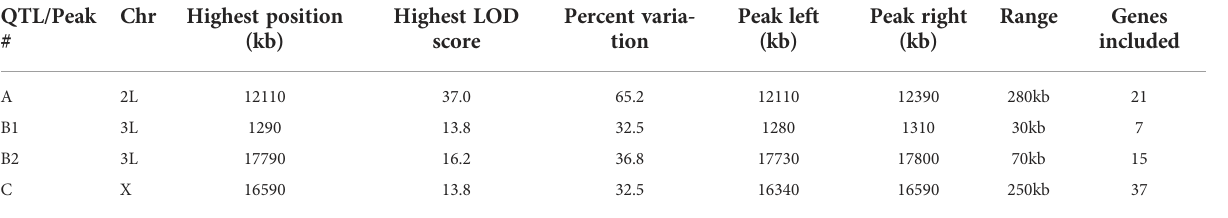
TABLE 1 QTL/LOD peaks identi fi ed in QTL analysis. QTL/Peak #